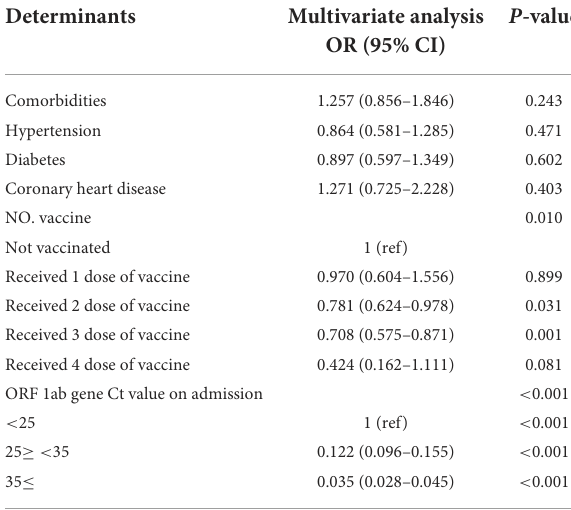
TABLE 3 Independent predictors of persistently PCR-positive patients identified by unadjusted and adjusted multivariate logistic regression